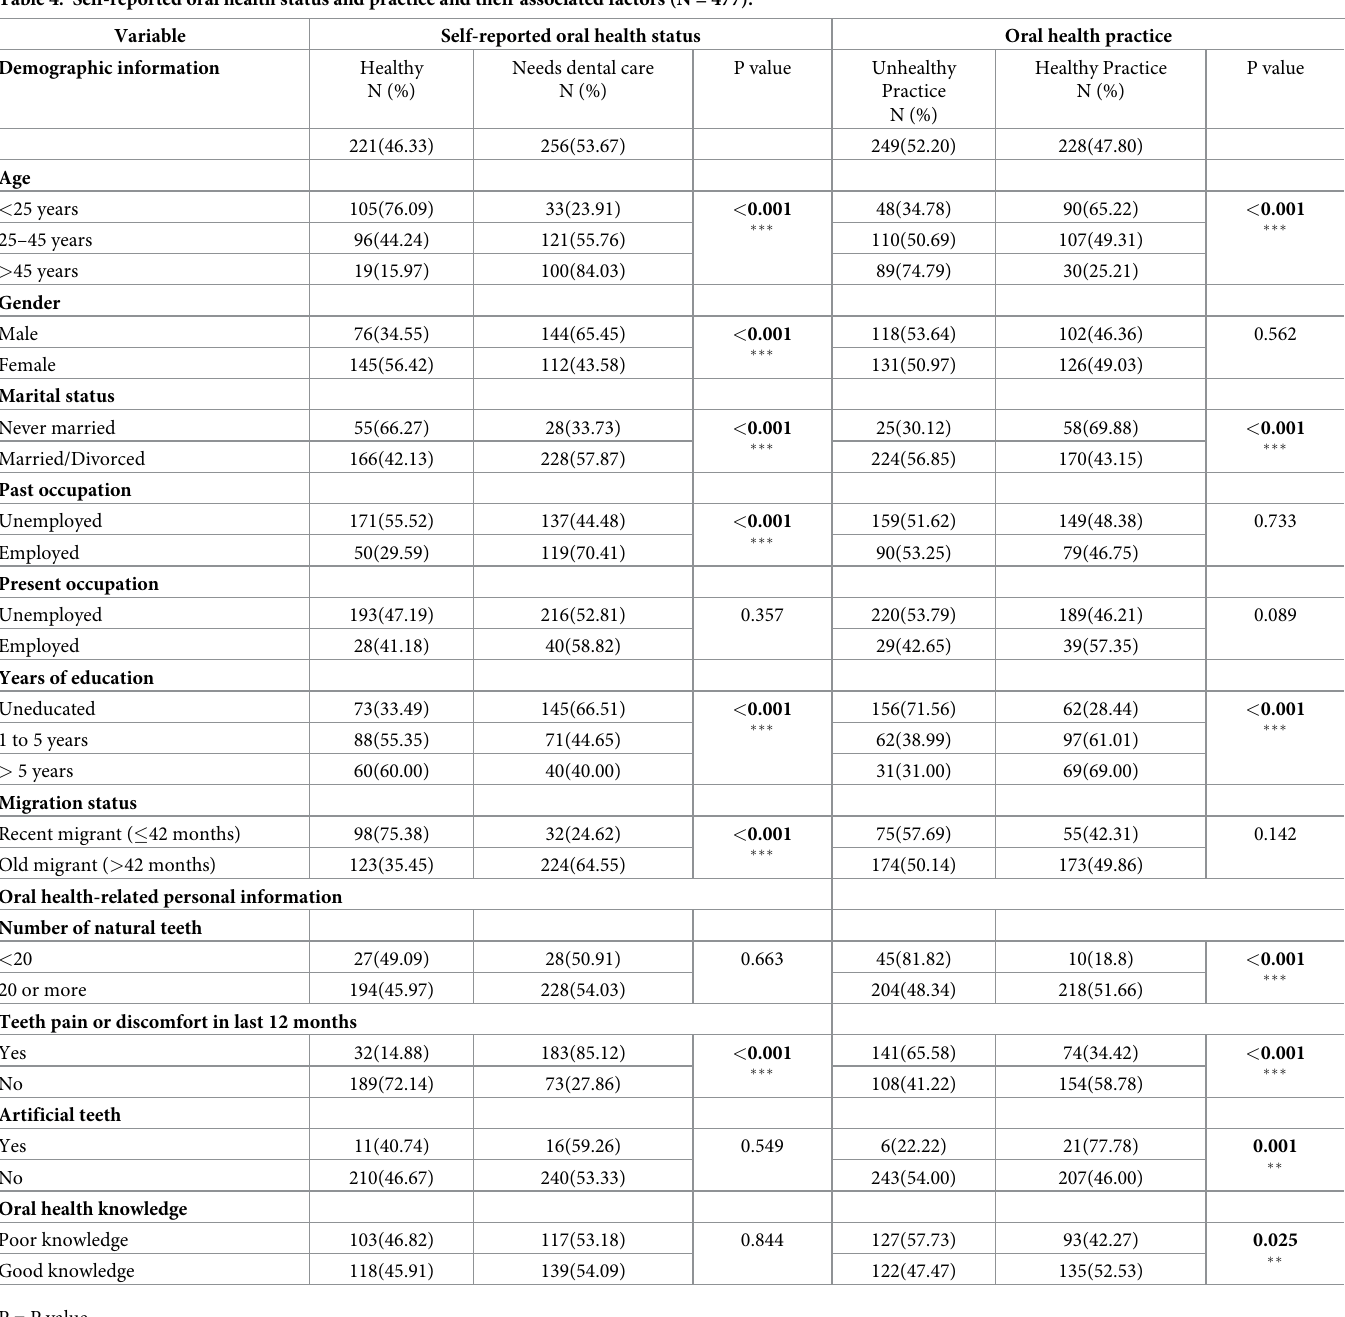
Table 4. Self-reported oral health status and practice and their associated factors (N =